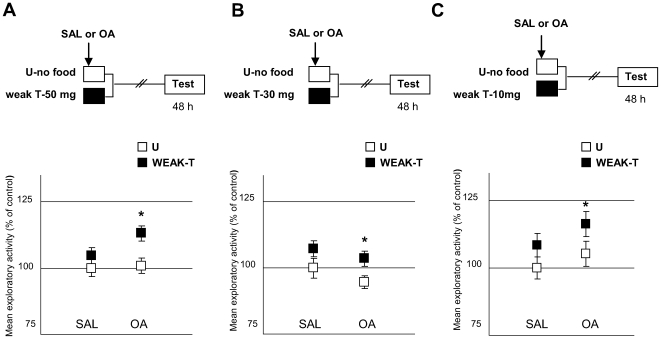
OA is able to disclose appetitive memory even when the quantity of food is reduced to a minimum.A) 50 mg of food (Upper diagram): Experimental protocol. A weak training protocol was used, consisting of a reduced amount of food (50 mg). Arrows stand for an injection of SAL (N = 35) or 4 mM OA (N = 35), applied at the onset of the weak appetitive training trial. (Lower panel): Results of the testing session. Ordinates and symbols as in Figure 6. B) 30 mg of food (Upper diagram): Experimental protocol. As in A, but with a pellet of 30 mg (N = 34 per group for SAL pair and N = 35 for OA pair). (Lower panel): Results of the Testing session. Ordinates and symbols as in Figure 6 C) 10 mg of food (Upper diagram): Experimental protocol. As in A, but with a pellet of 10 mg (N = 40 per group). (Lower panel): Results of the Testing session. Ordinates and symbols as in Fig. 6.